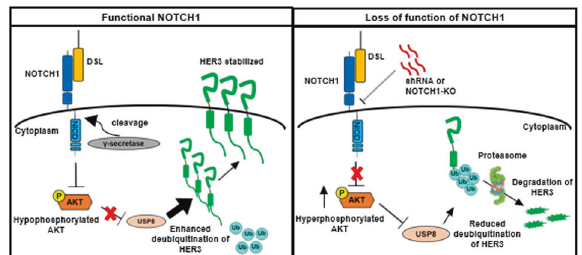
Fig. 5 Graphical abstract. Schematic illustration shows the working model of NOTCH1 regulation of HER3 protein. Functional NOTCH1 signaling suppresses the phosphorylation of AKT serine 473, which inactivates the deubiquitinating enzyme USP8. Activated USP8 then deceases the polyubiquitination of HER3, preventing proteasomal degradation of HER3 protein (left). When loss of function of NOTCH1 occurs, phosphorylation of AKT is increased, and the activity of USP8 is subsequently down-regulated. Once the deubi- quitination is suppressed, the poly-ubiquitinated HER3 protein is subject to proteasomal degradation various stages of precancerous lesions to SCCHN. In summary, our data suggested that NOTCH1 is a higher-ranked regulator of the AKT axis than HER3. As a consequence, our results offer some insight into how strategies and patient strati fi cation may be improved in future clinical trials for anti-HER3 therapeutics in SCCHN. Currently, various HER3-targeting therapeutic monoclonal antibodies have been developed and are entering clinical trials, including patritumab/U3 – 1287 [52], seribantumab/MM-121 [53], and lumretuzumab/RG7116 [54]. However, none of these HER3- targeting antibodies has been approved for clinical use because of unsatisfactory clinical bene fi t. Since NOTCH1 is inactivated in approximately one-tenth of SCCHN cases, and this aberration is a powerful activator of the AKT pathway and a negative regulator of HER3, exclusion of patients bearing NOTCH1-inactivated SCCHN tumors may be recommended for future clinical trials on HER3- targeting antibodies. In addition, the development of an antibody- drug conjugate (ADC), with a cytotoxic payload attached to an